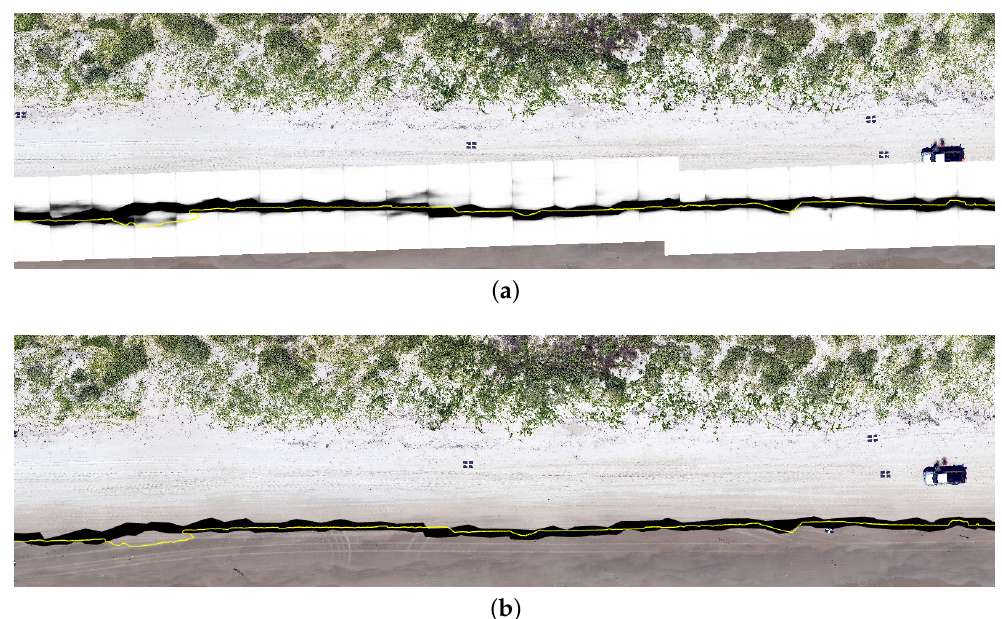
Figure 10. Georeferencing Neural Network Predicted Results (Flight 3). ( a ) shows the AI georefer- enced images overlaid over the orthomosaic, ( b ) compares the AI predicted (black) with the labeled wet/dry shoreline